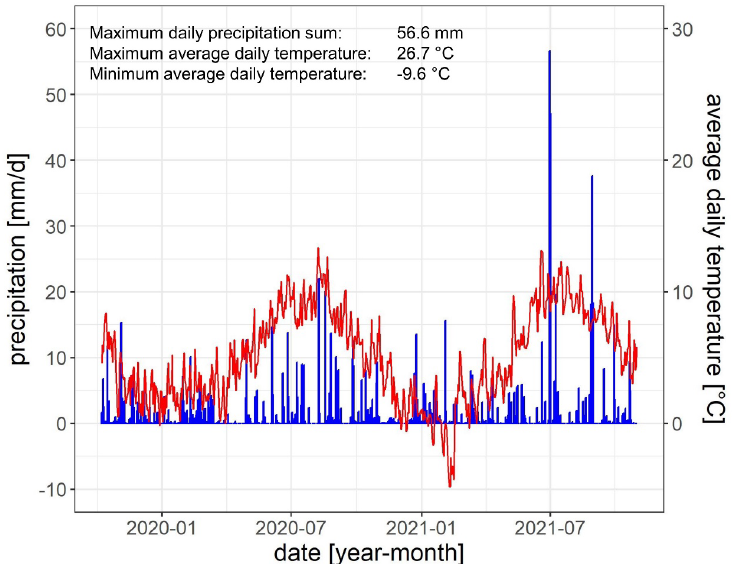
Figure 2. Daily precipitation ( blue line ) and average daily temperatures ( red line ) at the study site from 10 August 2019 to 31 October 2021.